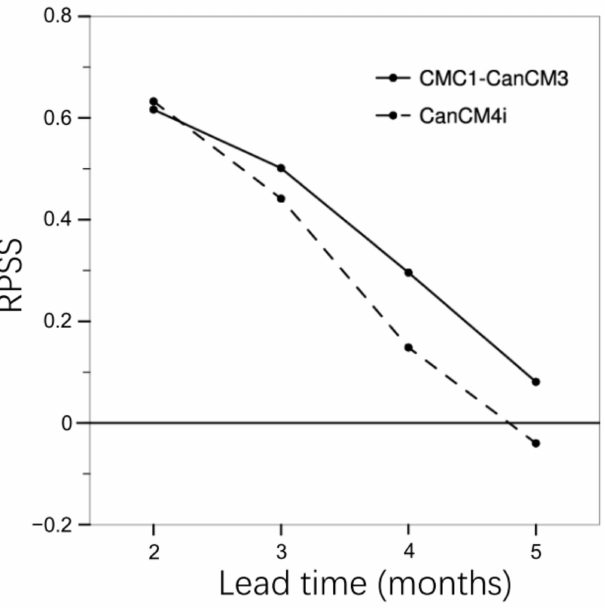
Figure 7. The RPSS as a function of lead time (month) for CMC1-CanCM3 (solid line) and CanCM4i (dashed